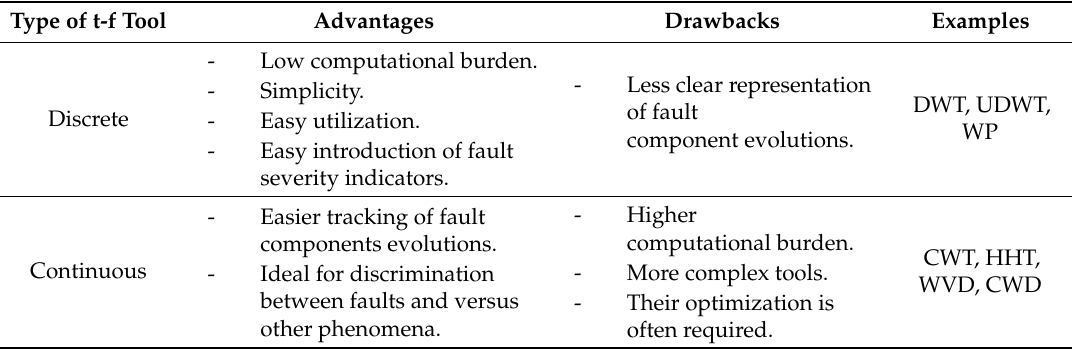
Table 2. Main time-frequency tools for the application of transient-based diagnosis approaches